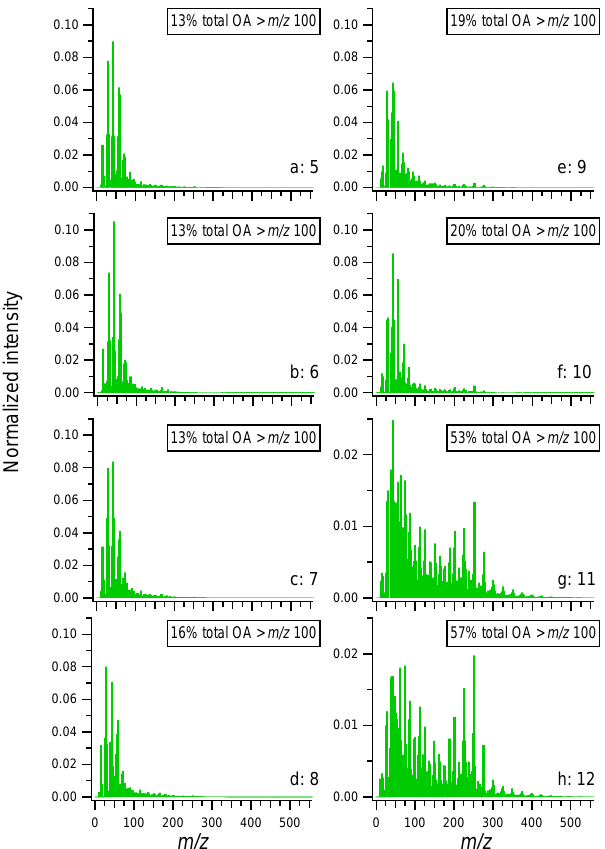
Figure 4. Primary organic aerosol mass spectra normalized to the total organic signal measured by the AMS from the SC for wood- combustion experiments 5–12 (a) – (h) . Experiments are ordered ac- cording to ascending contribution of mass above m/z 100 to the to- tal OA mass, which is given for each